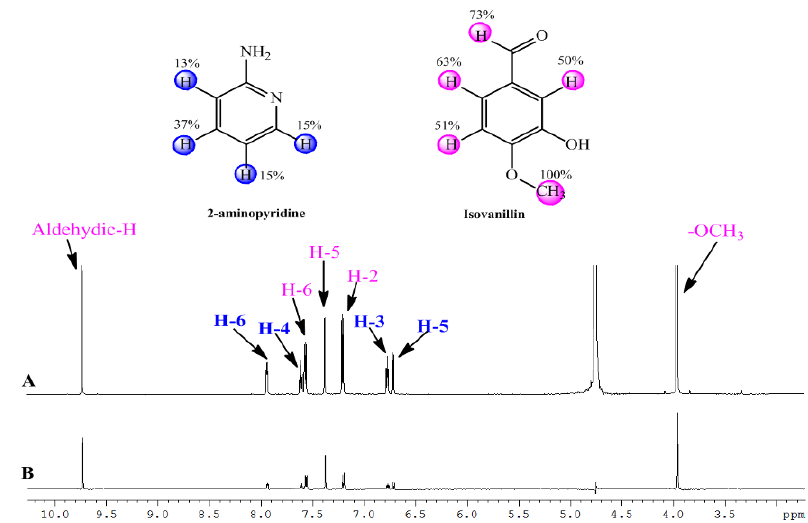
Figure 2. STD-NMR of 2-aminopyridine and isovanillin with BSA: (A) reference 1 H spectrum of 2-aminopyridine and isovanillin with BSA and (B) STD difference spectra of 2-aminopyridine (5mM) and isovanillin (5mM) with BSA(50 µM in phosphate buffer with pH 7.4). The relative STD amplification factors as calculated from STD difference spectrum are shown on the top of the